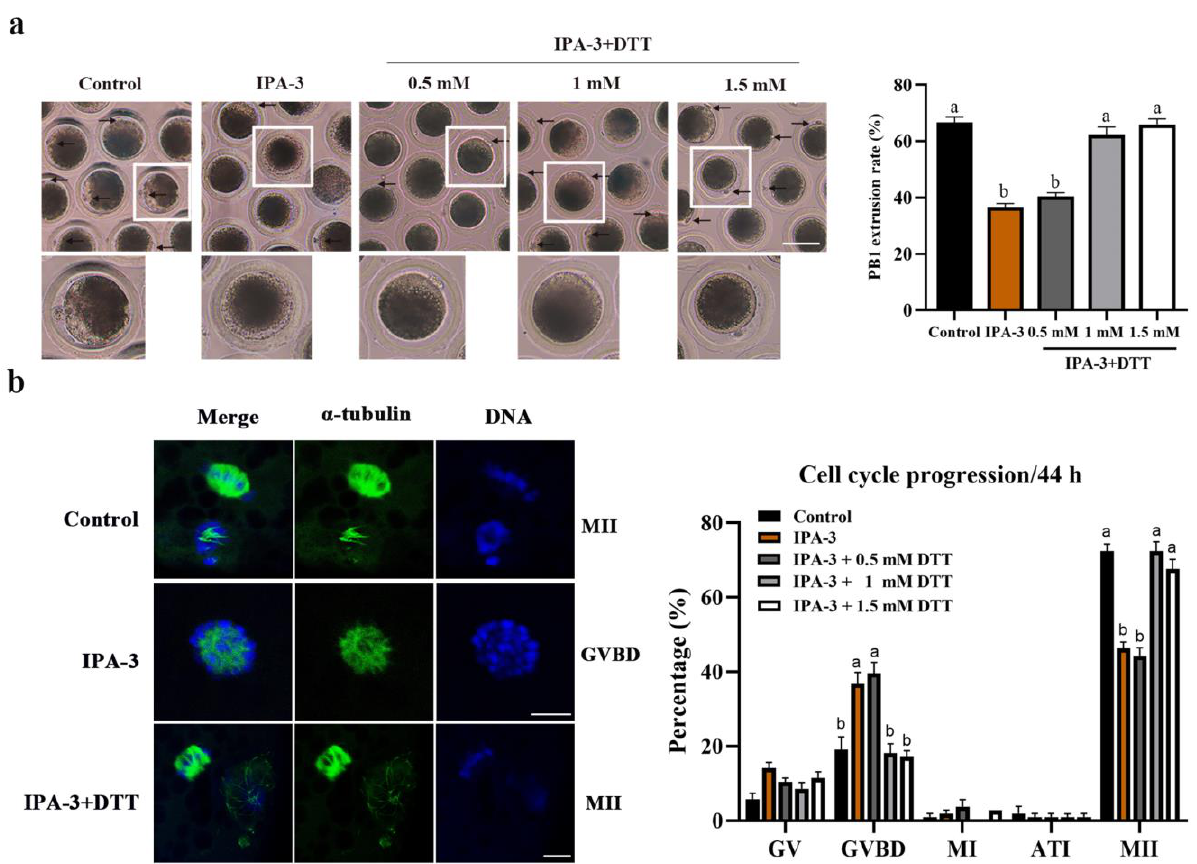
Figure 4. Effects of DTT on the maturation and cell cycle progression of IPA-3-treated oocytes. ( a ) Representative images of PB1 extrusion and the rate of PB1 extrusion in the control, IPA-3 and IPA-3 + DTT groups after 44 h of culture in vitro ( n = 105 for control group; n = 104 for 30 µM IPA-3 group; n = 104 for IPA-3 + 0.5 mM DTT group; n = 106 for IPA-3 + 1 mM DTT group; n = 106 for IPA-3 + 1.5 mM DTT group). Arrow, the PB1. Scale bars are 100 μm. ( b ) DTT restored the cell cycle progression of IPA-3-treated oocytes ( n = 105 for control group; n = 106 for 30 µM IPA-3 group; n = 106 for IPA-3 + 0.5 mM DTT group; n = 105 for IPA-3 + 1 mM DTT group; n = 105 for IPA-3 + 1.5 mM DTT group). Green, α-tubulin. Blue, chromosome. Scale bars are 10 μm. a, b Values with different